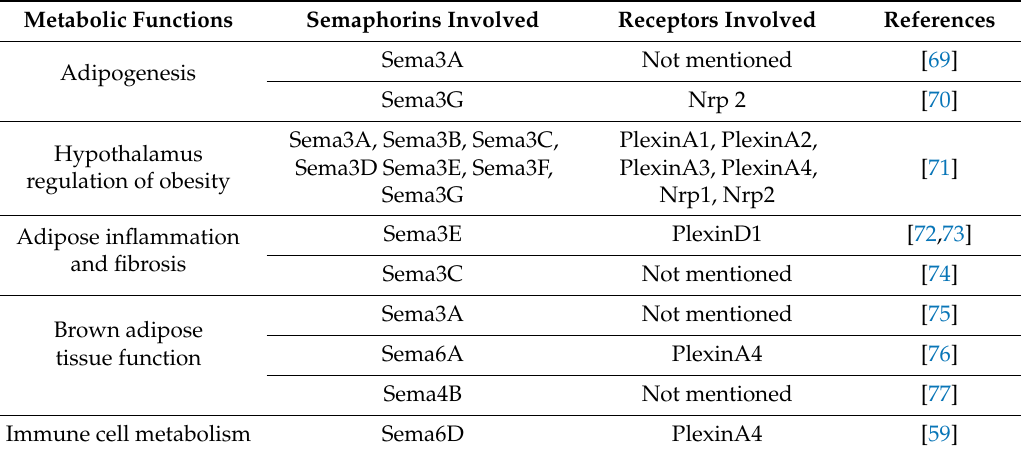
Table 2. Semaphorins in